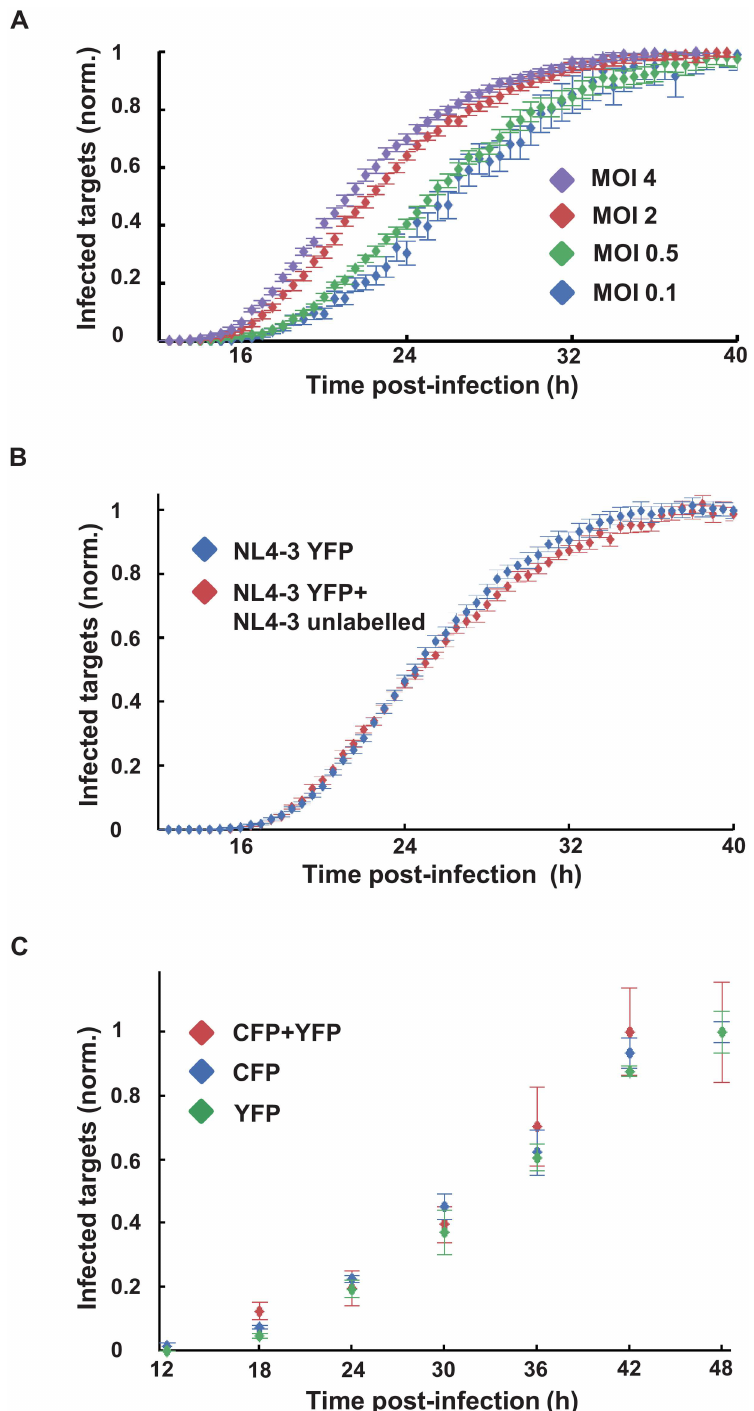
Fig 3. Earlier onset of HIV gene expression by multiple infections per cell. ( A ) Timing of HIV gene expression onset as a function of multiplicity of infection (MOI) per cell. MT4 cells were infected with HIV strain NL4-3YFP at an MOI of 0.1 (blue), 0.5 (green), 2 (red) and 4 (purple). Shown are means and standard errors over 15 FOVs. One of three independent experiments.( B ) Measurement of cooperativity between infecting viruses. Infection as detected using YFP expression when cells were infected with NL4-3YFP alone at MOI of 0.3 (blue), or with YFP at the same MOI co-infected with unlabeled NL4-3 at an MOI of 8 (red).